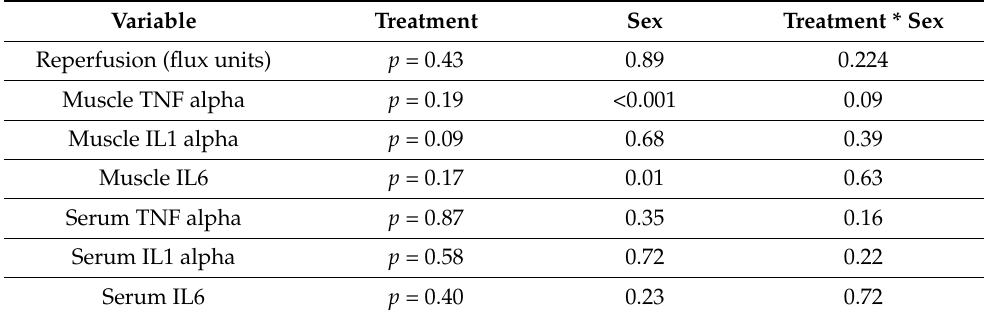
Table 2. ANOVA results from parameters examined in mice treated with vehicle or low-dose (50 ug) extracellular vesicles.